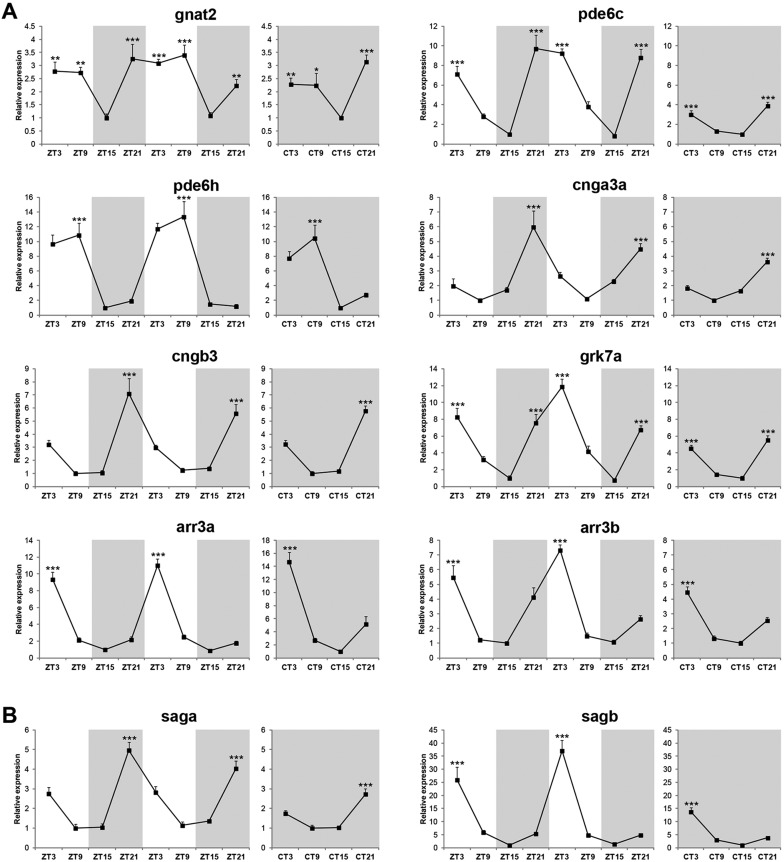
Phototransduction genes are also rhythmically expressed in the zebrafish adult retina. qPCR analysis of cone-specific (A) and rod-specific (B) phototransduction genes in zebrafish adult eyes over two days of an LD cycle and one subsequent day of DD (n=3-4). Zeitgeber time (ZT) or circadian time (CT) indicates the four time points analysed per day. White and grey backgrounds represent light and dark phases, respectively. Statistically significant differences between the expression peak and trough on each day (Fisher's LSD test) are indicated: *P<0.05, **P<0.01, ***P<0.001. Error bars indicate s.e.m.